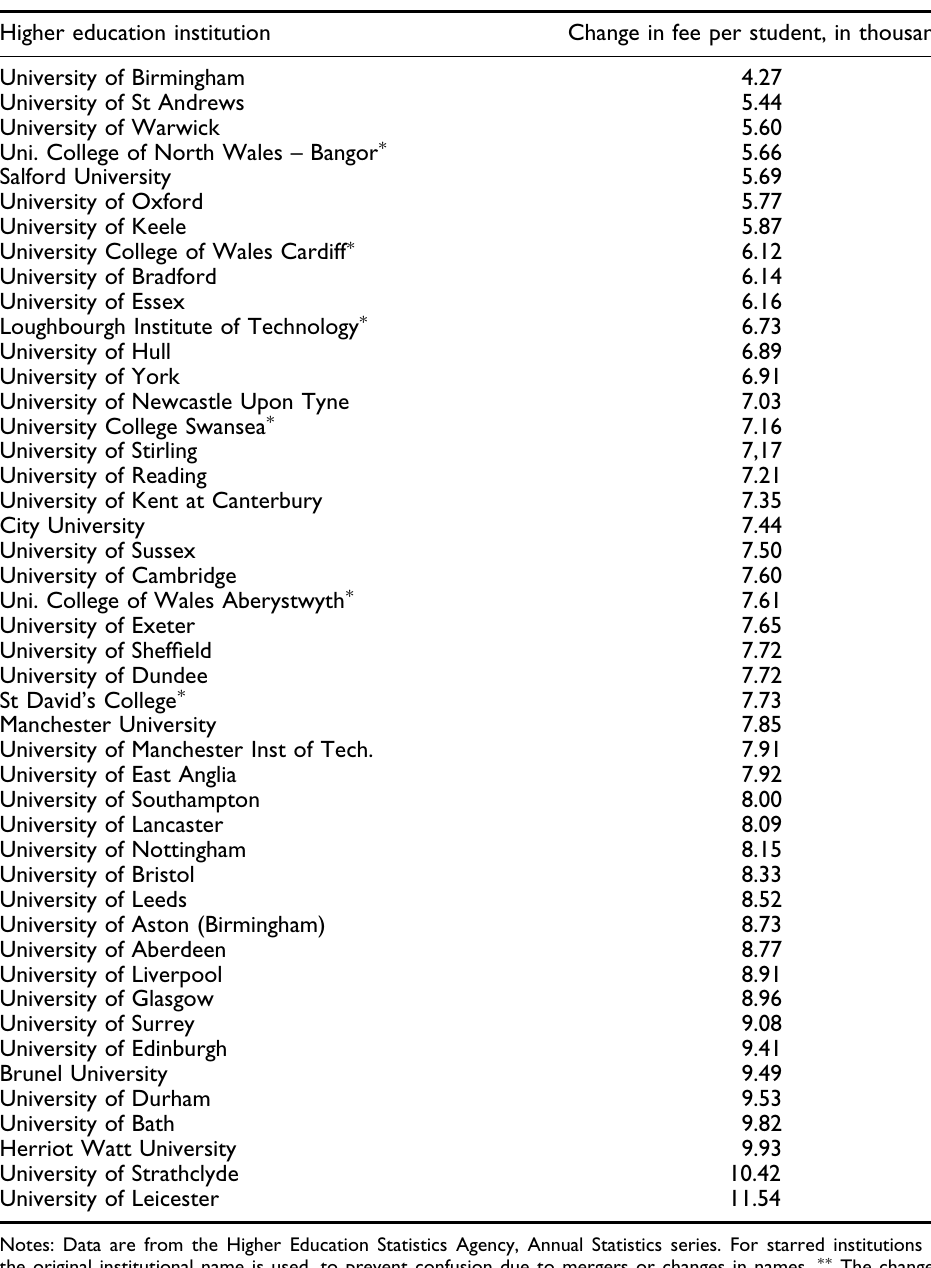
Table 1. Change in the fee per international student, from 1979 to 2004 ⁄⁄ . Higher education institution Change in fee per student, in